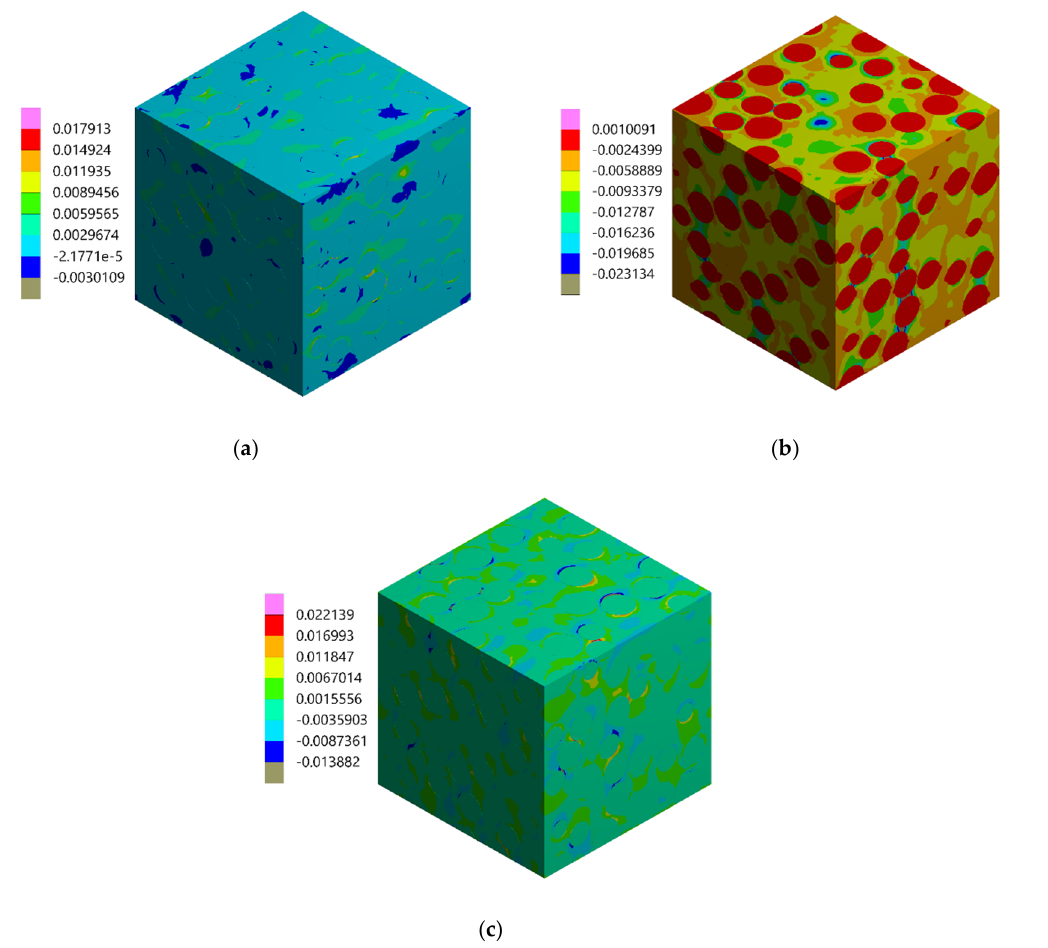
Figure 12. Strain distributions obtained by using FEM: ( a ) component ε xx , ( b ) component ε yy , ( c ) component ε xy.